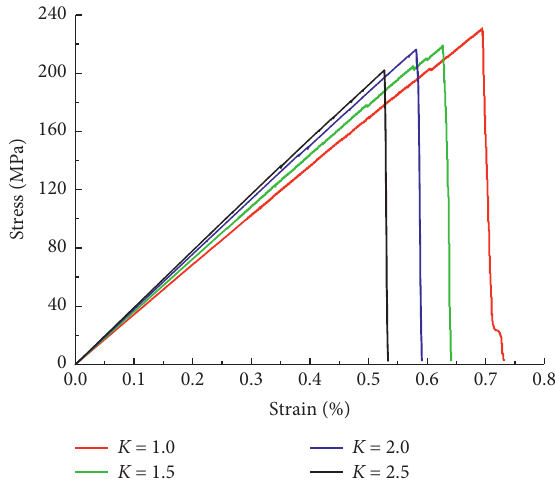
Figure 5: Stress-strain curves of rocks with different values of K . Table 2: Macro mechanical parameters of rocks with different values of K . Numerical specimen